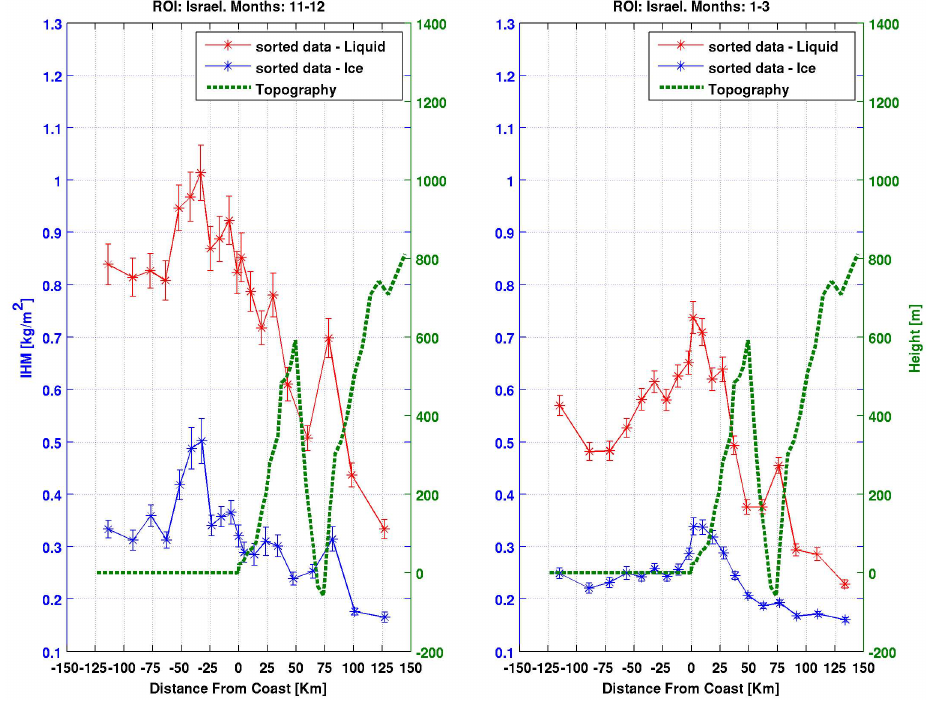
Fig. 6. Mean IHM (kgm − 2 ) as a function of the distance from the nearest EM coastline, left figure corresponds to November–December months, and right figure to January–March. Positive (negative) x-axis distances correspond to rain over land (sea). The data was sorted into 20 bins according to distance from nearest coastline and divided into liquid (Red astrix curve) and ice (Blue astrix curve) phases. Error bars represent standard error of the mean. Mean topography profile (dashed green curve) is included; Judea and Jordan ridges reach their highest elevation at 46km and 115km, respectively. The November–December, January–March counts per bin are 1184, 2550 for liquid IHM and 1002, 2433 for ice IHM,